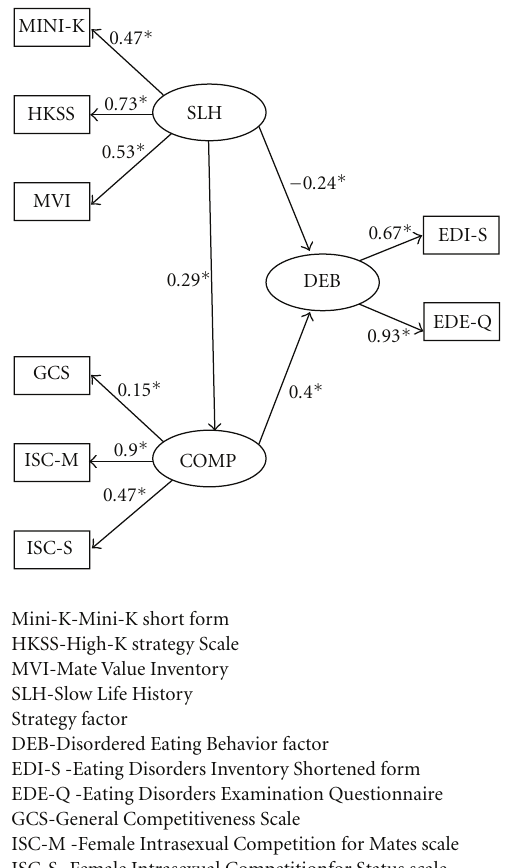
Figure 1: Factor Analytic Structural Equation Model for Evolutionary Psychology of Disordered Eating Behaviors in Female Undergraduates.